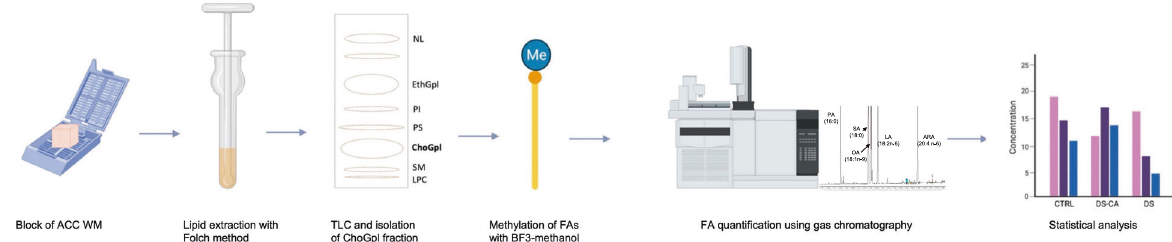
Fig. 1 Graphical overview of FA quanti fi cation methodology. NL: neutral lipids (e.g., cholesterol), EthGpl: ethanolamine glyceropho- spholipids, PI: phosphatidylinositol, PS: phosphatidylserine, ChoGpl: choline glycerophospholipids, SM: sphingomyelin, LPC: lysopho- sphatidylcholine. Figure was created using